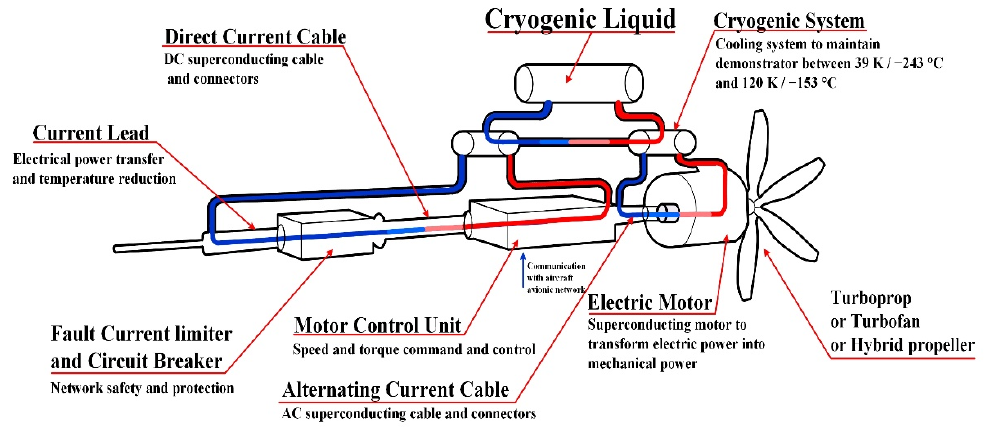
Figure 12. Operation principle of the ASCEND concept to power hydrogen-based aircraft (inspired by [67]).